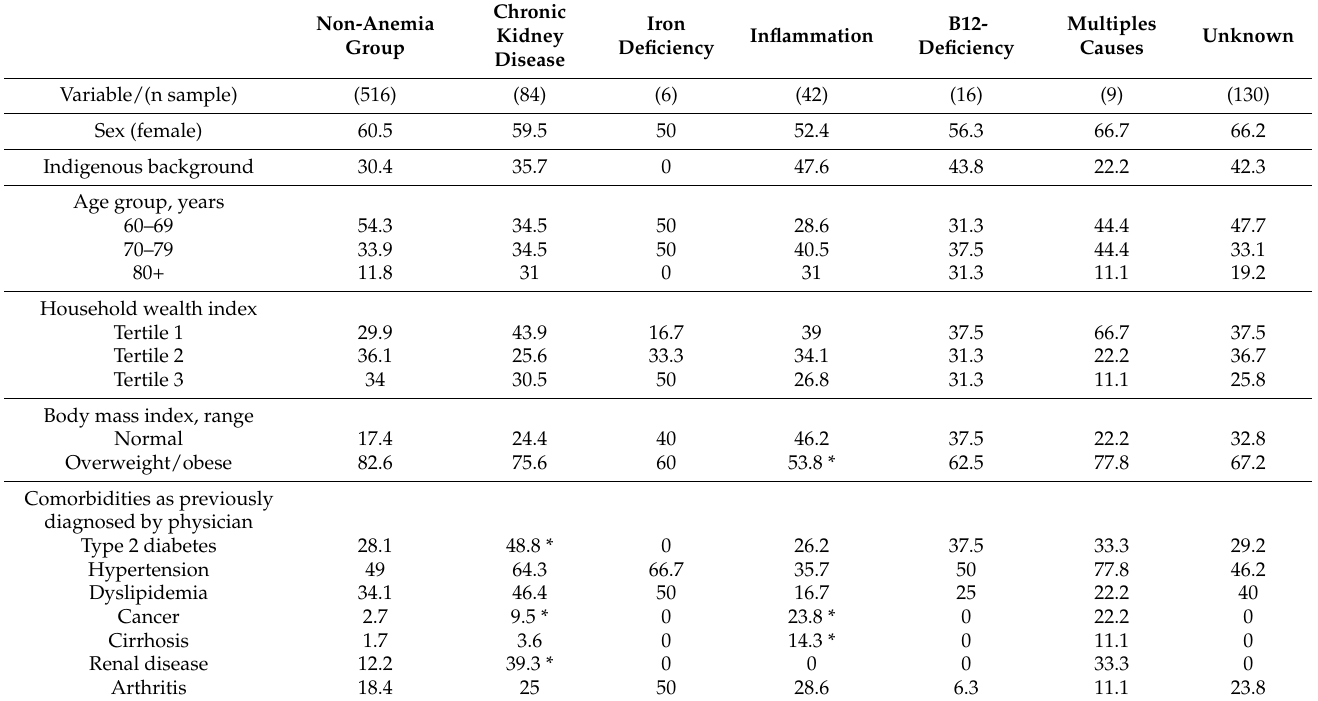
Table 3. Descriptive characteristics of older adult study population, by etiology of